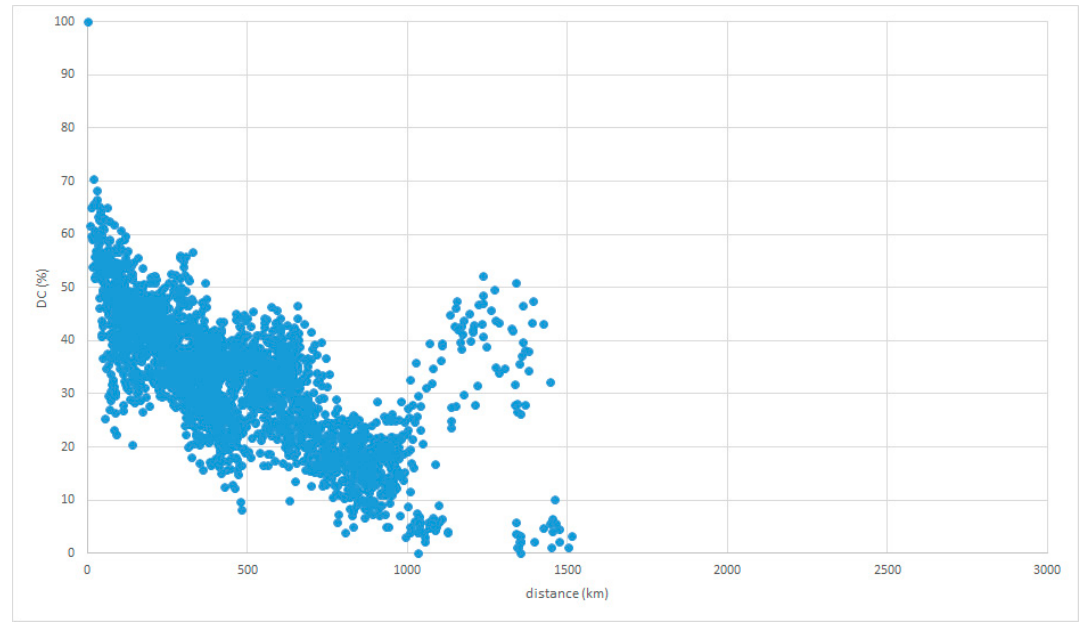
Figure 8. LAJ data with reference place in Chugoku.